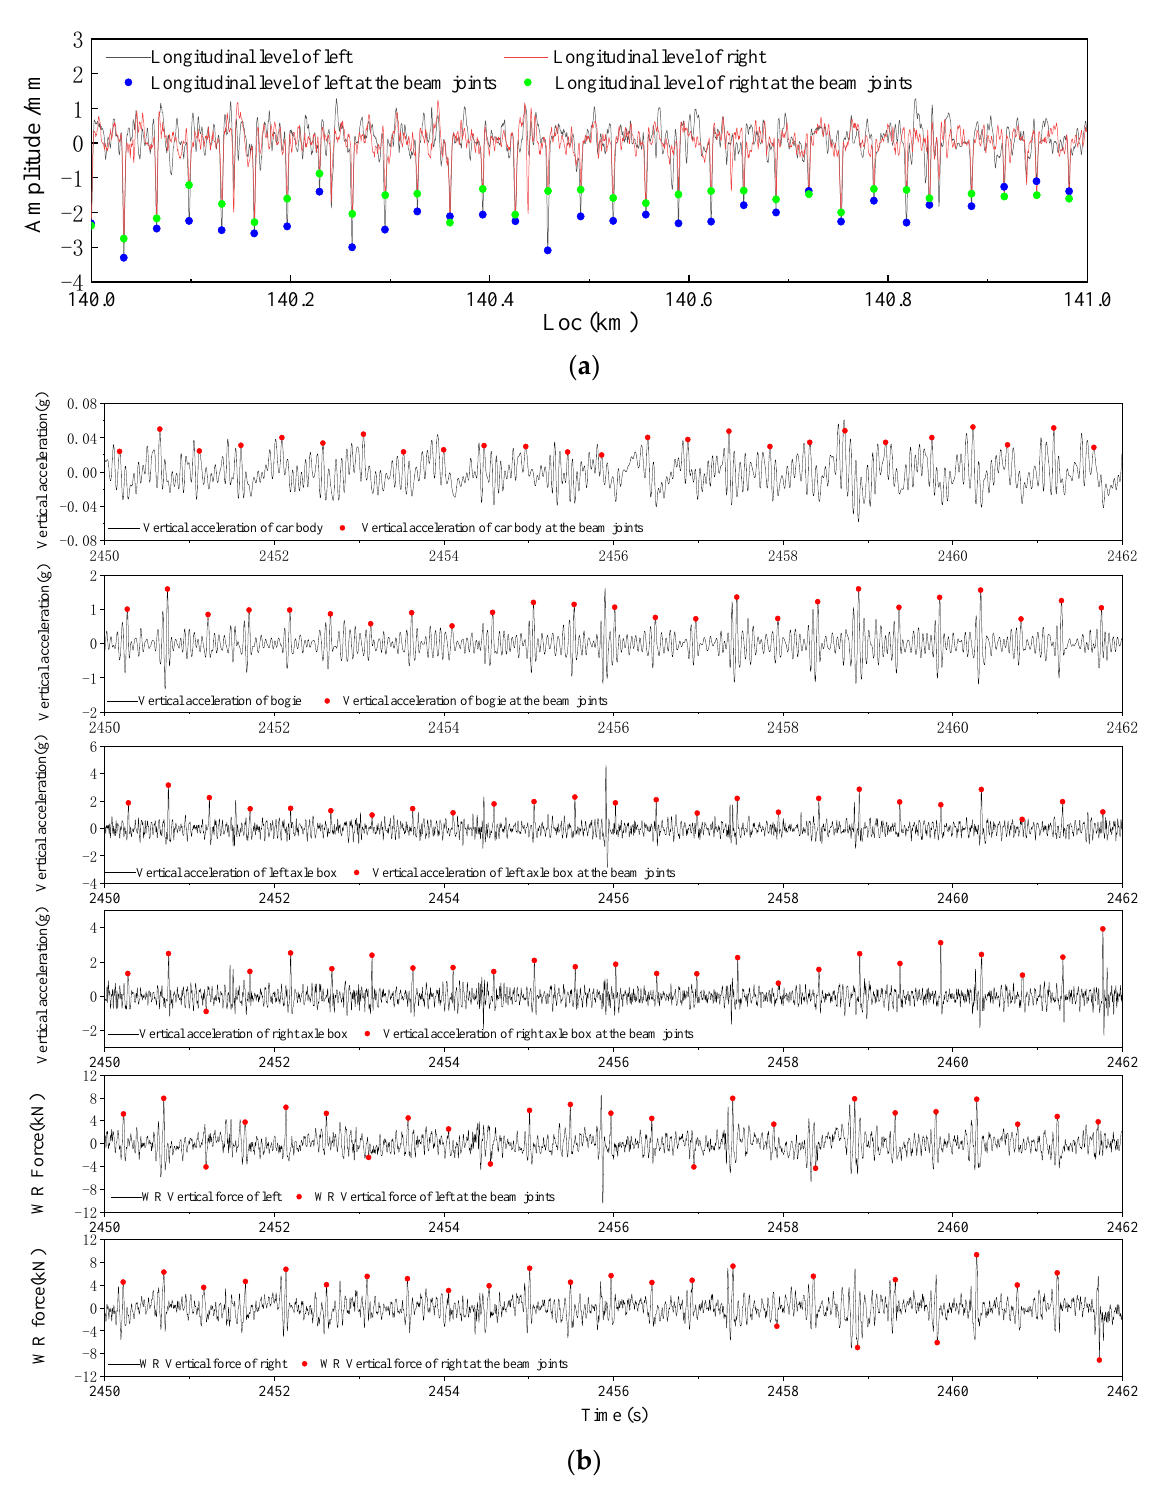
Figure 10. Time history curves of vehicle dynamic responses and WR force. ( a ) Track longitudinal level (section). ( b ) Vehicle dynamic response data.